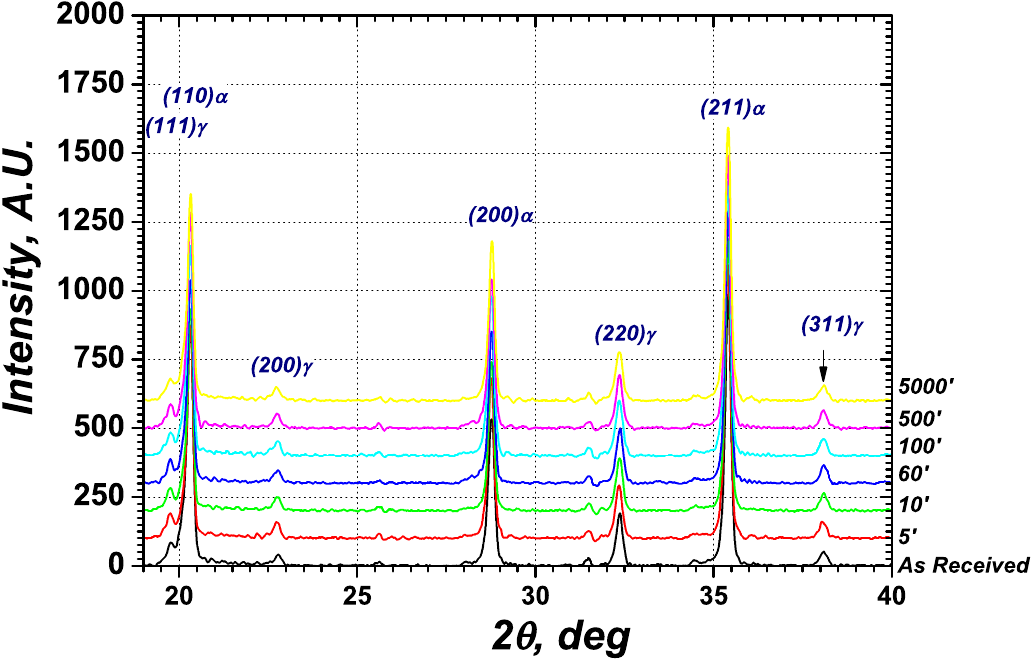
Figure 14. XRD diffractogram for the TRIP5 steel after aging at 170 ◦ C for 5, 10, 60, 500, and 5000 min.